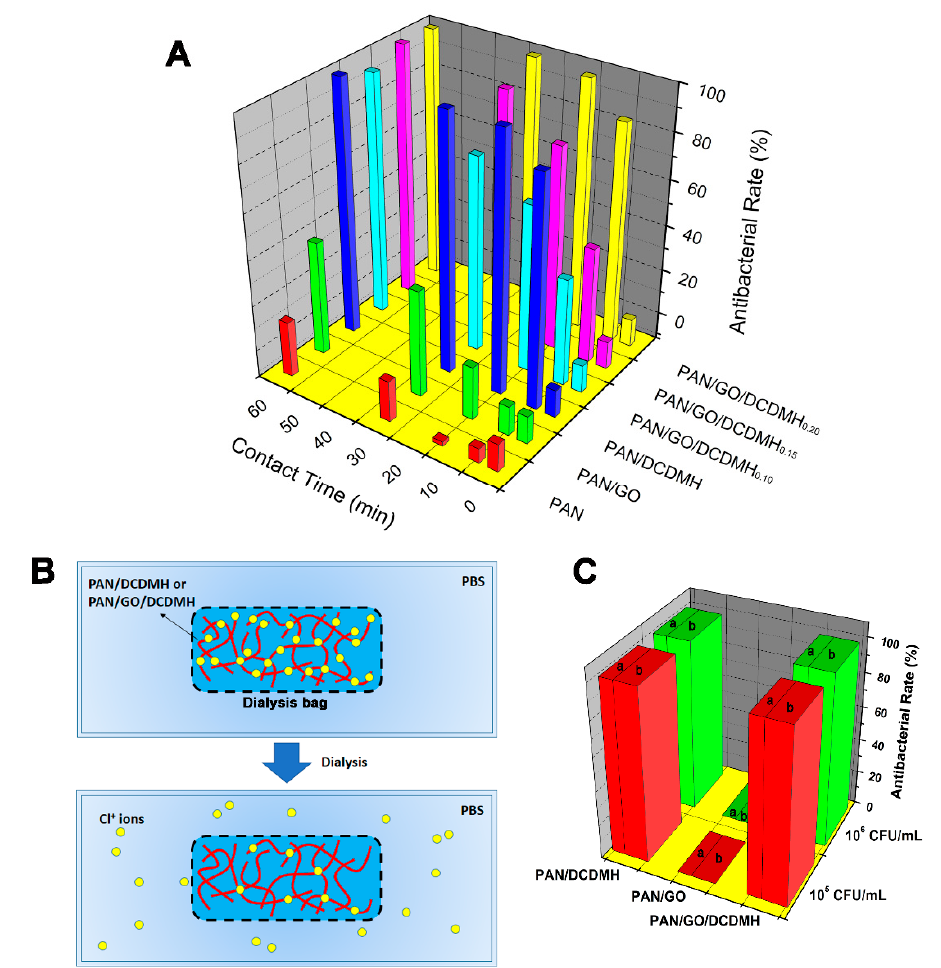
Figure 8. ( A ) Time-kill assay with fibrous membranes against E. coli . ( B ) Schematic illustration of dialysis test. ( C ) Antibacterial rate of dialysate solution from PAN/GO, PAN/DCDMH, and PA/GO/DCDMH with different suspension concentrations of ( a ) 2 mg ∙ mL − 1 and ( b ) 5 mg ∙ mL − 1 against 10 5 and 10 6 CFU ∙ mL − 1 of E. coli .